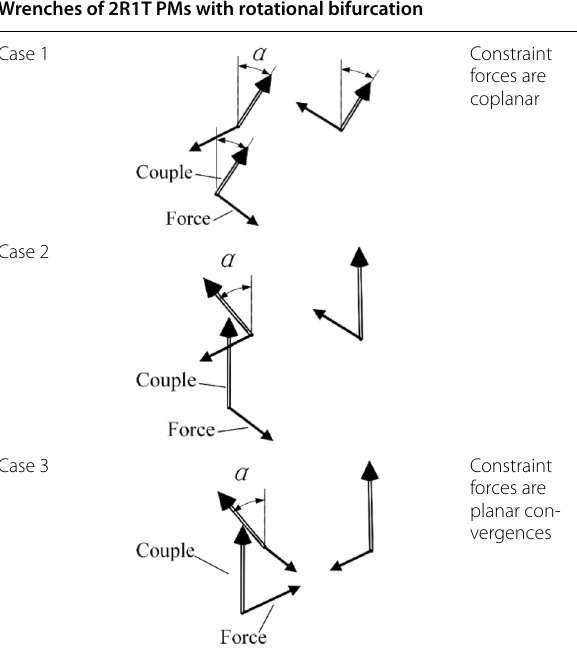
Table 1 Constraint wrenches of 2R1T PMs with